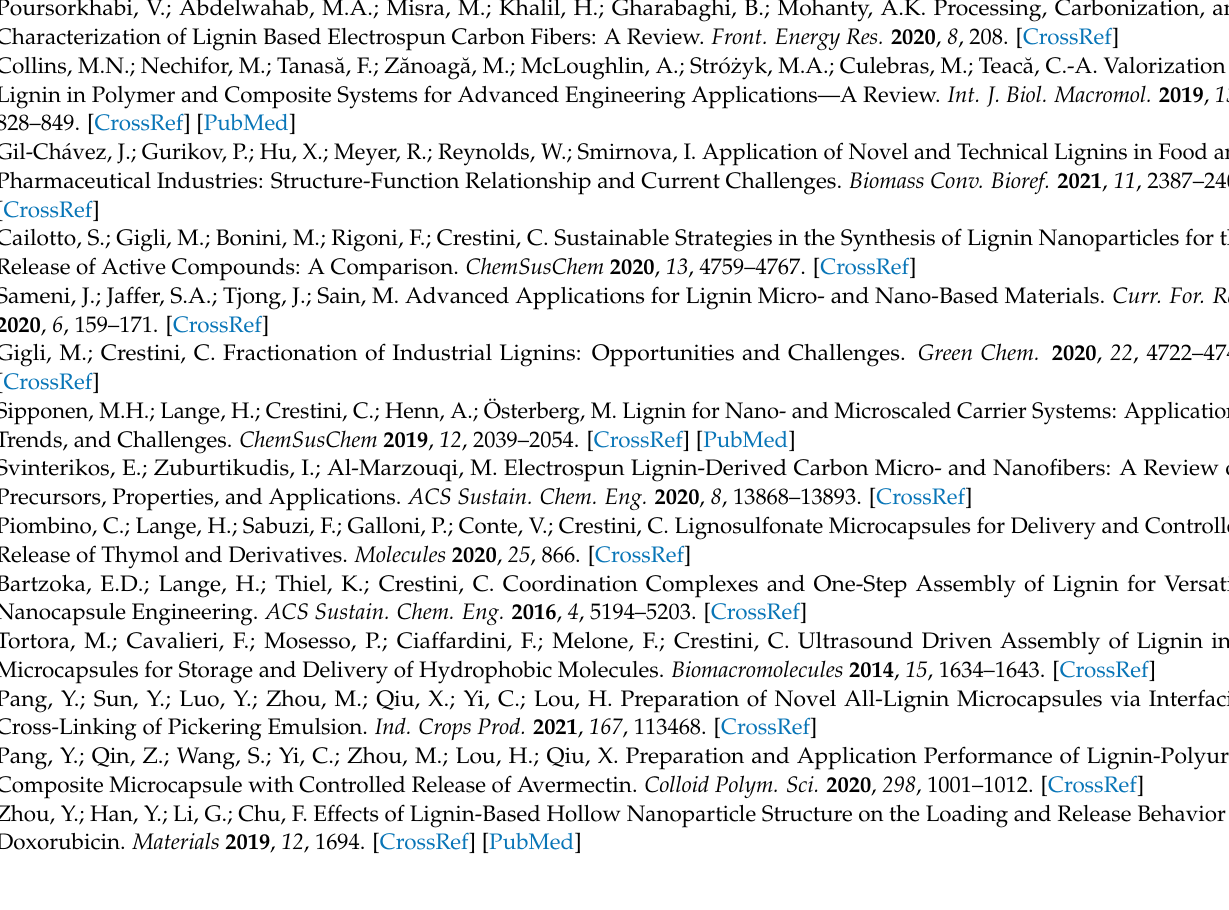
Figure S2: 1 H-NMR of diveratryl sebacate, Figure S3: Photographs of LMCs after the centrifuga- tion step, Figure S4: Photographs of LMCs (sample) after incubation at pH 4 for 24 h, Figure